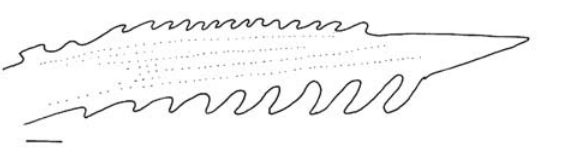
Fig. 2. Left pectoral-fin spine of Microglanis pataxo , MNRJ 28398, paratype. Dorsal view. Scale bar, 1 mm.